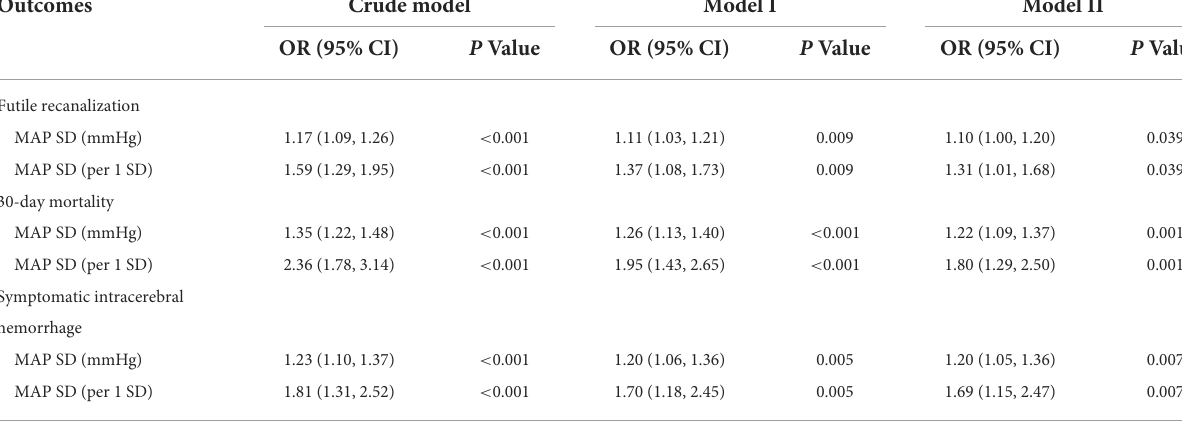
TABLE 2 Multivariable regression of MAP SD associated with clinical